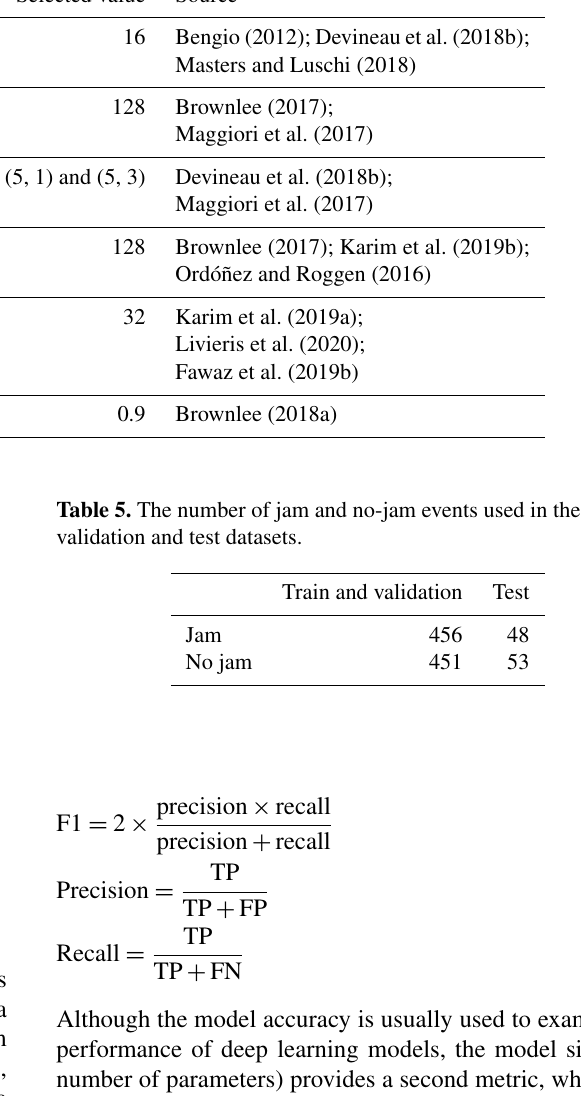
Table 3. Common and selected values for different parameters of the models. Parameter